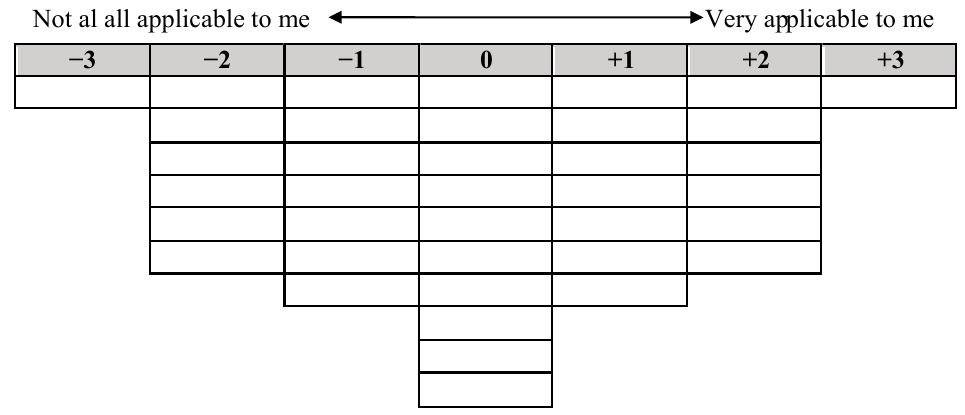
Figure 1. Representation of the grid for the Q-sort used in the online sorting procedure. Participants assigned all 40 statements on the places on the grid.